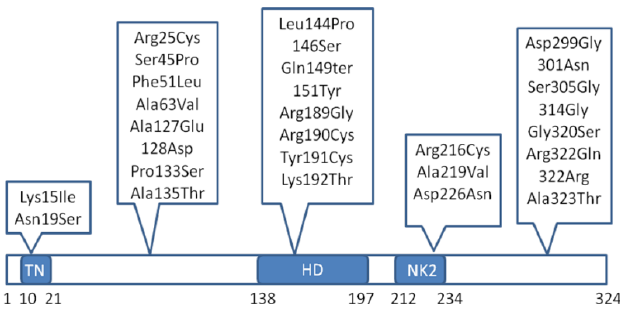
Figure 2. Spectrum of some significant NKX2-5 gene mutations implicated in congenital heart